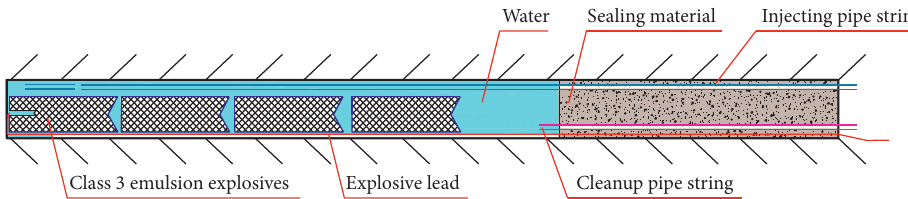
Figure 9: In-hole charge line connecting diagram.